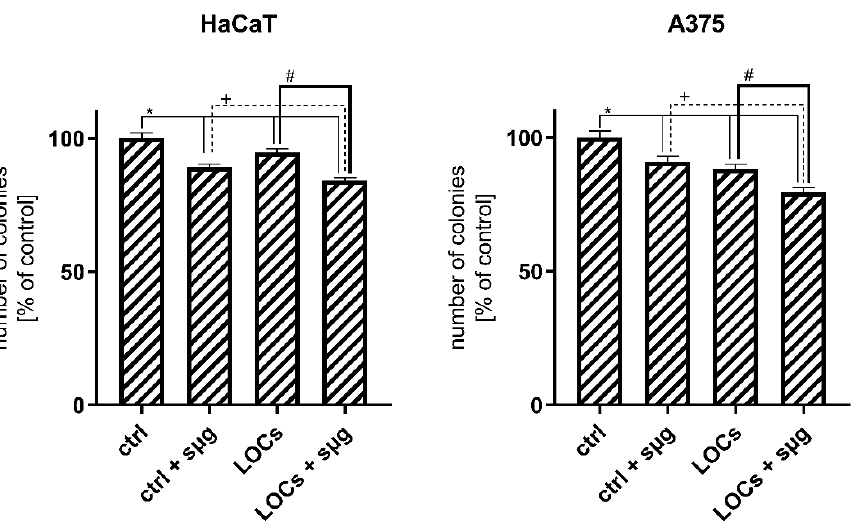
Figure 4. Number of colonies (% of control cells) after the exposure to simulated microgravity